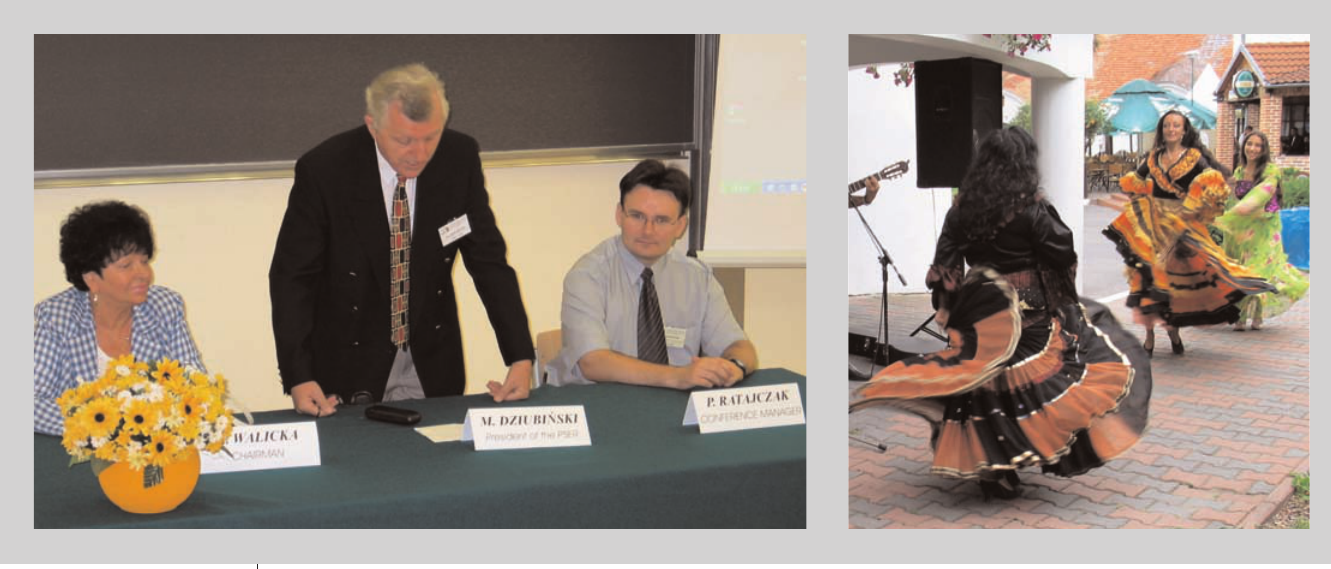
Figure 1 (left): Opening ceremony. From left to right: Prof. A. Walic- ka, Prof. M. Dziubinski, and P. Ratajczak. Figure 2: Gipsy team on the confer- ence